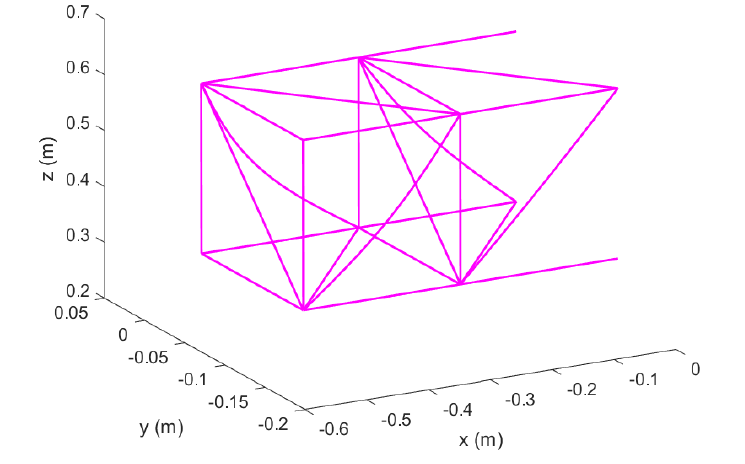
Figure 19. Mode 2 of Euler–Bernoulli Beams in Topology 1 with hinged ends; original configuration.